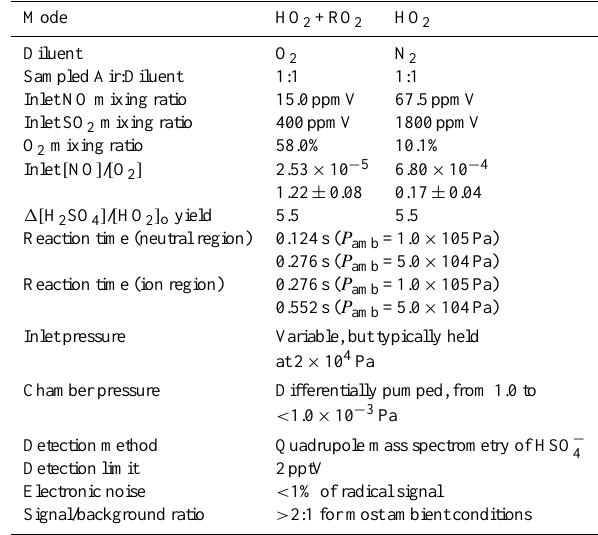
Table 1. Standard Ambient PeRCIMS Operating